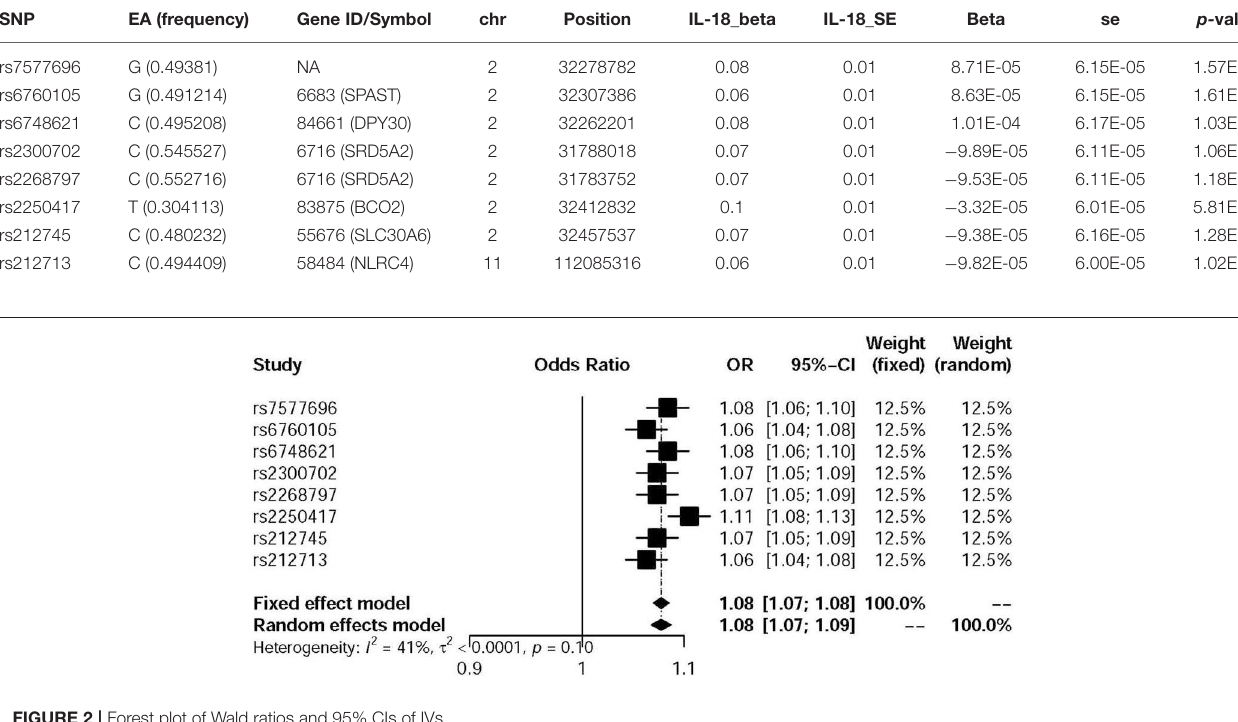
FIGURE 2 | Forest plot of Wald ratios and 95% CIs of IVs.